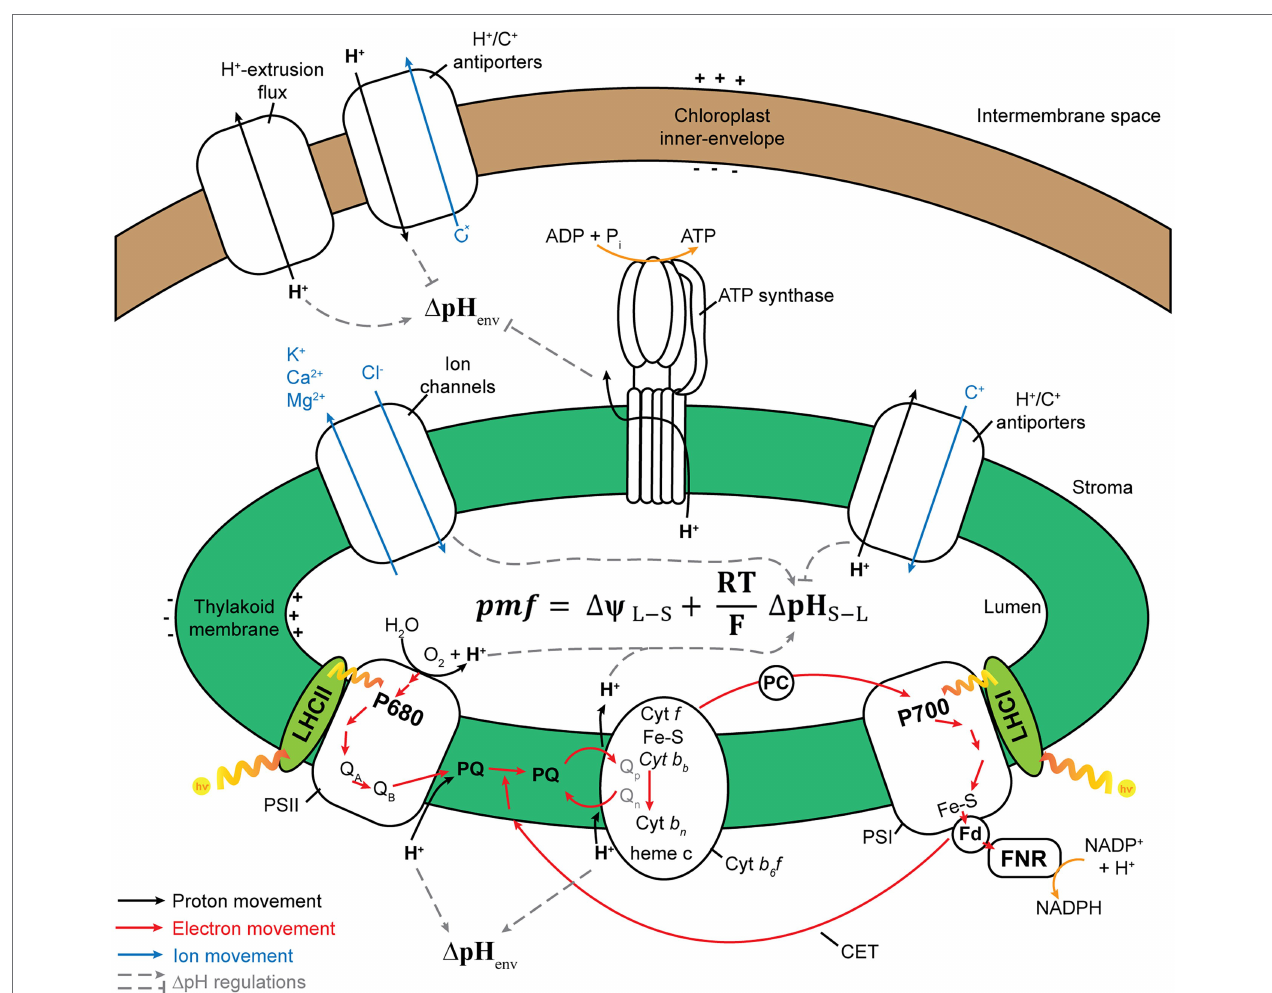
FIGURE 2 | Schematic model of processes that contribute to proton motive force ( pmf ). PSII, photosystem II; Cyt b 6 f , cytochrome b 6 f ; PQ, plastoquinone/ plastoquinol pool; PSI, photosystem I; LHC, light-harvesting antenna complex; PC, plastocyanin; Fd, ferredoxin; CET, cyclic electron transfer; FNR, ferredoxin– NADPH reductase. Photosynthetic electron transfer reactions at the PSII and Cyt b 6 f complex are coupled to H + transport from the stroma into the thylakoid lumen. These H + are deposited in the lumen during the oxidation of water at the PSII and then transported across the membrane through PQ. The active transport of H + / ions from one side of the thylakoid membrane to another generates pmf . Alternative electron transport pathways through the CET modulate the ratio between the number of H + translocated across the thylakoid membrane and the number of electrons transferred from water to NADPH. The chloroplast ATP synthase uses pmf and H + efflux from the thylakoid lumen, along with the phosphorylation of ADP, to form ATP. By increasing or decreasing the ∆ pH, ion flux via the thylakoid ion channels and H + antiporters modulates the composition of pmf . The pmf (mV) is calculated using the following equation: pmf = ∆ψ L denotes the electric potential between the lumen side and the stromal side of the thylakoid membrane; ∆ pH S and the lumen side of the thylakoid membrane; F denotes the Faraday constant; R denotes the gas constant; and T denotes the temperature. The H + gradient across the chloroplast envelope membrane ( ∆ pH env ) is calculated using the following equation: ∆ pH env = pH S – pH C , where pH S denotes the stromal pH, and pH C denotes the cytosol pH. This figure is adapted from Armbruster et al. (2017), Ptushenko et al. (2019), and Stirbet et al.